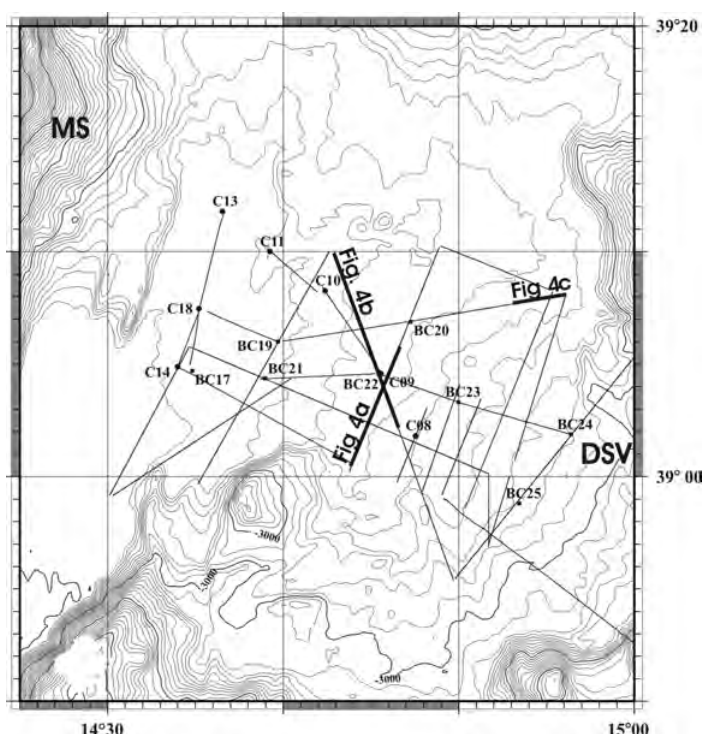
Fig. 3. Traces of Chirp profiles (thin lines) and location and number of seafloor samples (symbols as in fig. 2) collected in the Eastern Marsili Basin. Bold lines correspond to the line segments shown in fig. 4a-c. (DSV – Distal part of the Stromboli Valley; MS – Marsili